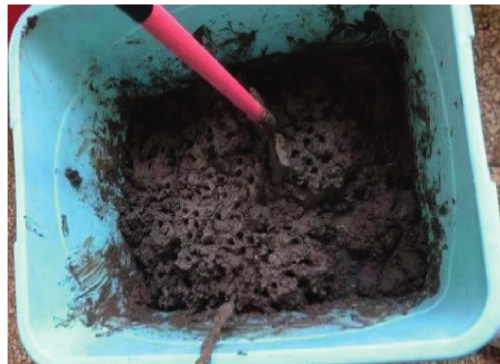
Figure 9: Remodeling soil after adding water.